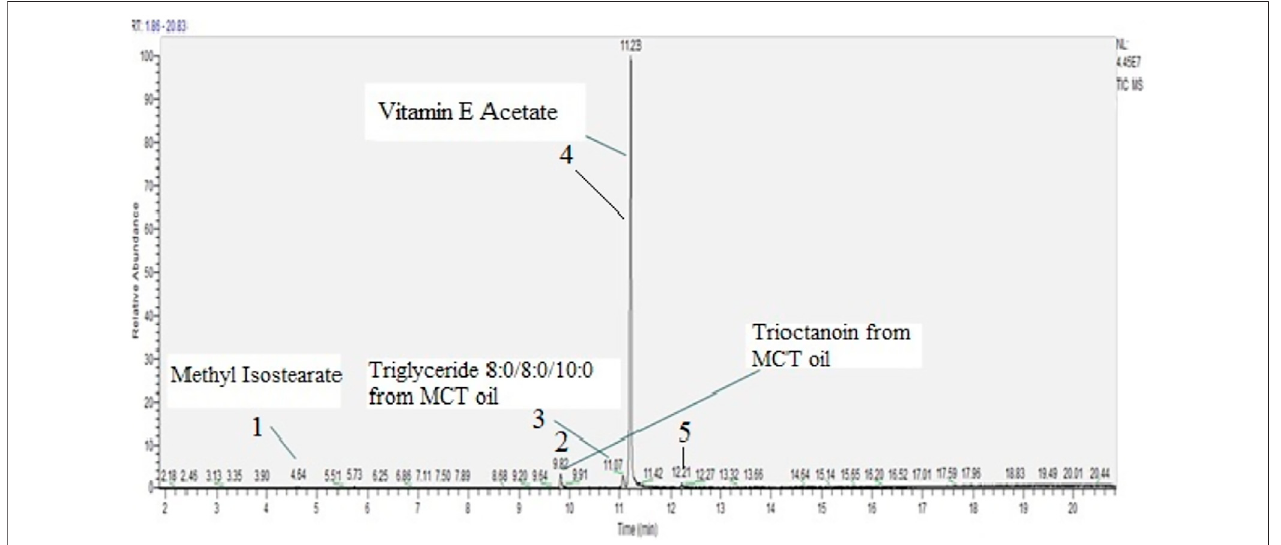
FIGURE 5 | D, L vitamin E acetate emission scan, concentration 870 µg/mL, including two MCT oil cross-contaminants.